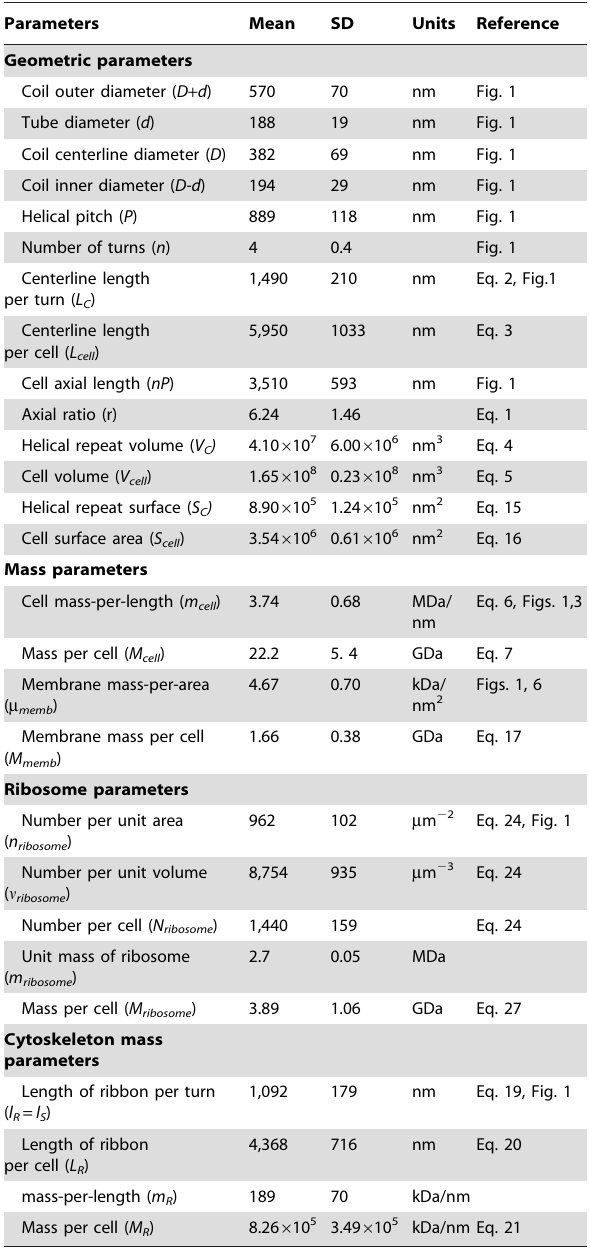
Table 1. Geometric Parameters of Spiroplasma Cells.